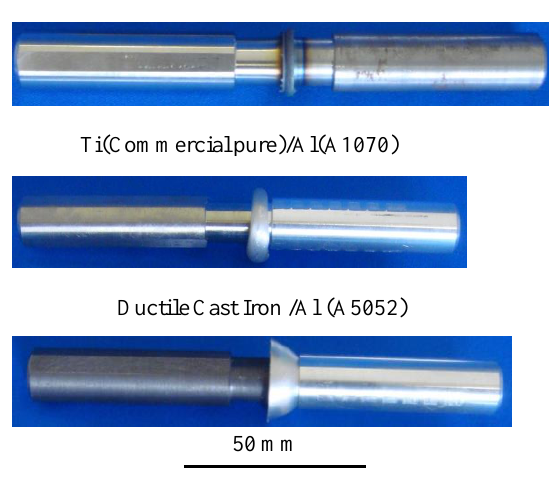
Figure 1. The pictures of the bimetallic specimens. Table 2. Friction welding conditions for fabricating the dissimilar metallic specimens.